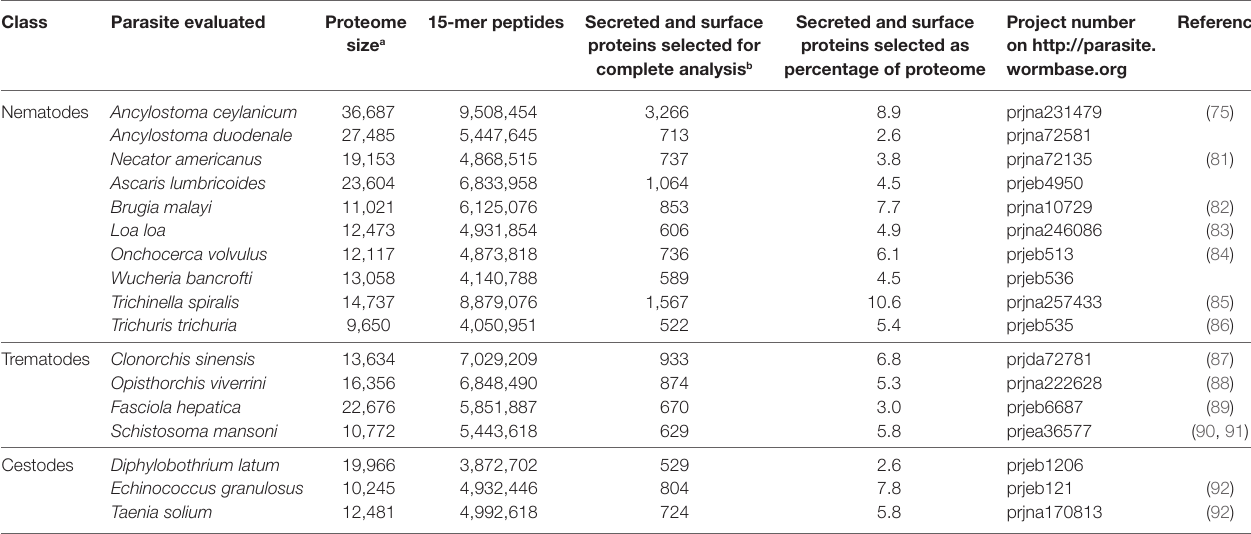
Table 1 | Helminth proteomes